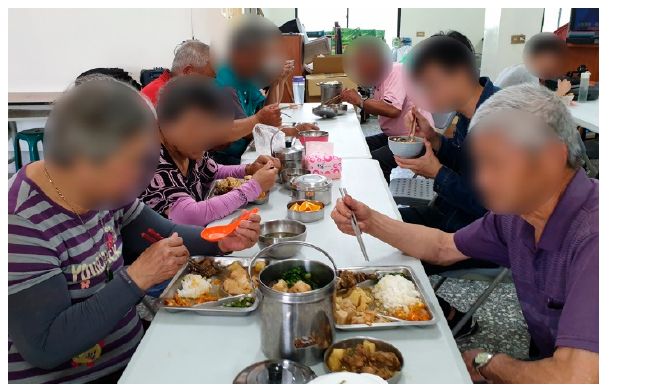
Figure 1. Aging process of Taiwan [2].